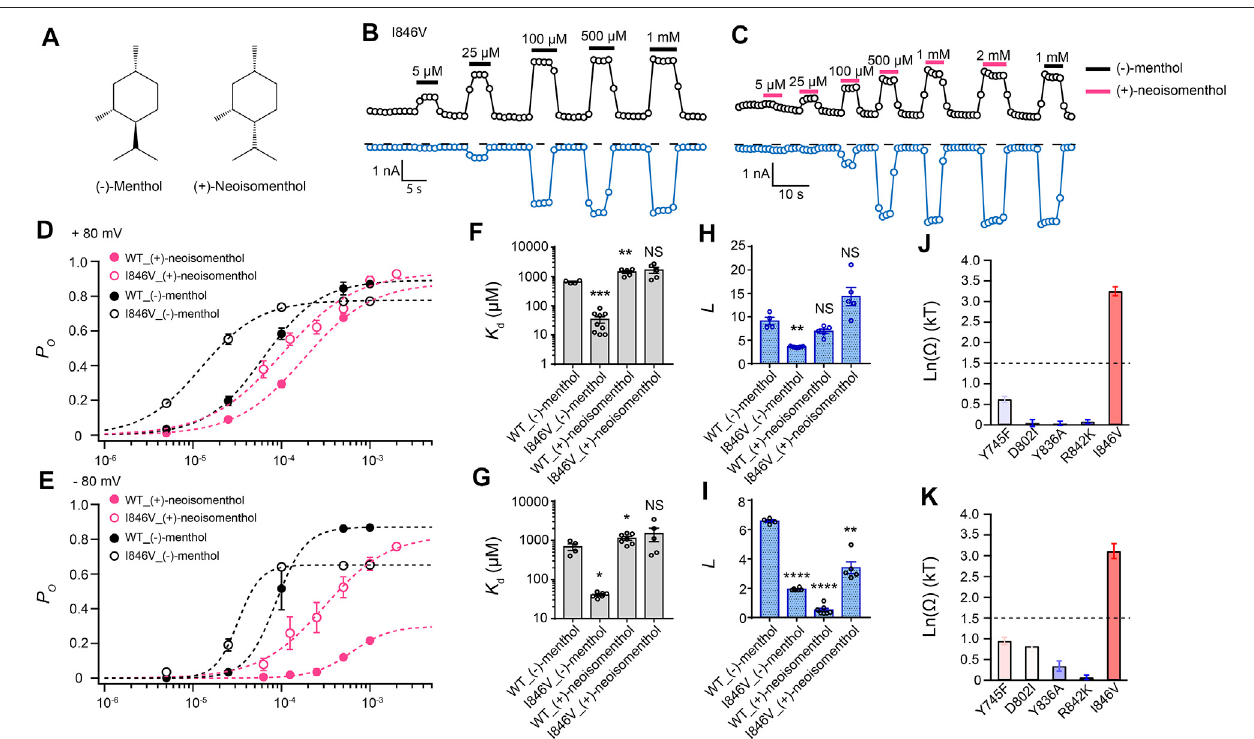
FIGURE 2 | Differential interactions between mouse TRPM8 and ( − )-menthol or (+)-neoisomenthol revealed by TMCA. (A) Comparison of chemical structures of ( − )-menthol and (+)-neoisomenthol is shown. (B) Representative whole-cell recordings of the I846V mutant channel activated by ( − )-menthol in a concentration- dependent manner. (C) Representative whole-cell recordings of the I846V mutant channel by (+)-neoisomenthol in a concentration-dependent manner. (D) Concentration – response curves of wild type and mutant such as I846V with either (-)-menthol or (+)-neoisomenthol activation were measured from whole-cell patch-clamp recordings at +80 mV ( n = 5 – 9). (F) and (H) For wild type and I846V channel, K d and L values at +80mV were calculated from the concentration – response curves in (D) (two-sided t -test, * p < 0.05; ** p < 0.01; *** p < 0.001; **** p < 0.0001; NS, not statistically signi fi cant). (J) Summary of coupling energy measurements at +80 mV. Coupling energy was calculated from the K d values. Mutants showing a coupling energy larger than 1.5kT (dashed line) were colored in red. Those with less energy were colored in different shades of blue. At least four independent trials were performed for each chemical at each concentration. (E) Concentration – response curvesofwildtypeandmutantsuchasI846Vwitheither( − )-mentholor(+)-neoisomentholactivationweremeasured fromwhole-cellpatch-clamprecordingsat − 80 mV ( n = 5 – 9). (G) and (I) For wild type and I846V channel, K d and L values at -80 mV were calculated from the concentration – response curves in (E) (two-sided t -test, * p < 0.05; ** p < 0.01; *** p < 0.001; **** p < 0.0001; NS, not statistically signi fi cant). (K) Summary of coupling energy measurements at -80 mV. Coupling energy was calculated from the K d values. Mutants showing a coupling energy larger than 1.5kT (dashed line) were colored in red. Those with less energy were colored in different shades of blue. At least four independent trials were performed for each chemical at each concentration.